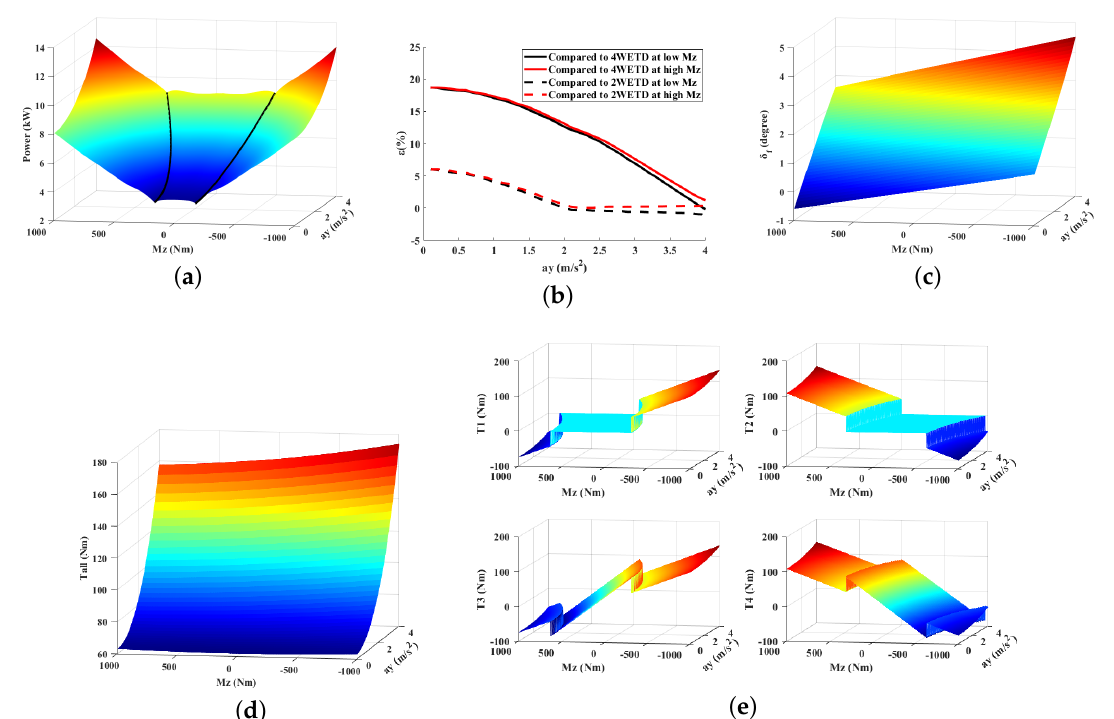
Figure 4. Results for constant velocity cornering with Motor I: ( a ) Minimal power; ( b ) Percentage of energy saving; ( c ) Steering angle; ( d ) Total torque; ( e ) Optimal wheel